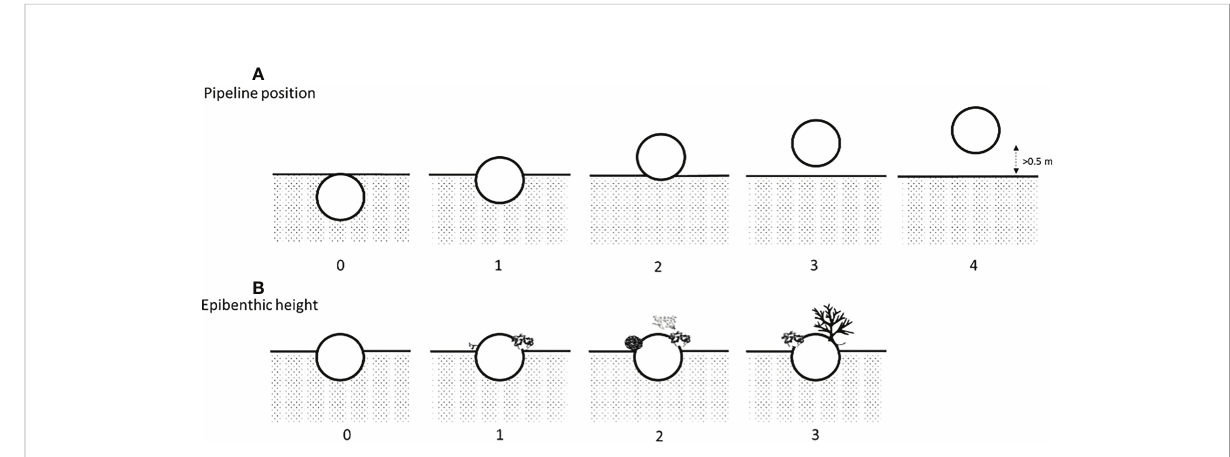
FIGURE 2 (A) Method of assessing pipeline position with 0: buried; 1: more than half buried; 2: resting on the sea fl oor; 3: span< 0.5 m; and 4: span > 0.5 m and (B) epibenthic height with 0: negligible; 1: low (0 – 20 cm); 2: medium (20 – 40 cm); and 3: high (> 40 cm). A version of this fi gure has previously been published in McLean et al.,